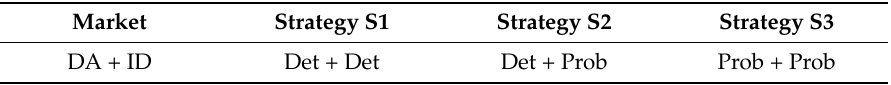
Table 5. Possible aggregator strategies to participate in the DA plus intraday (ID) markets.